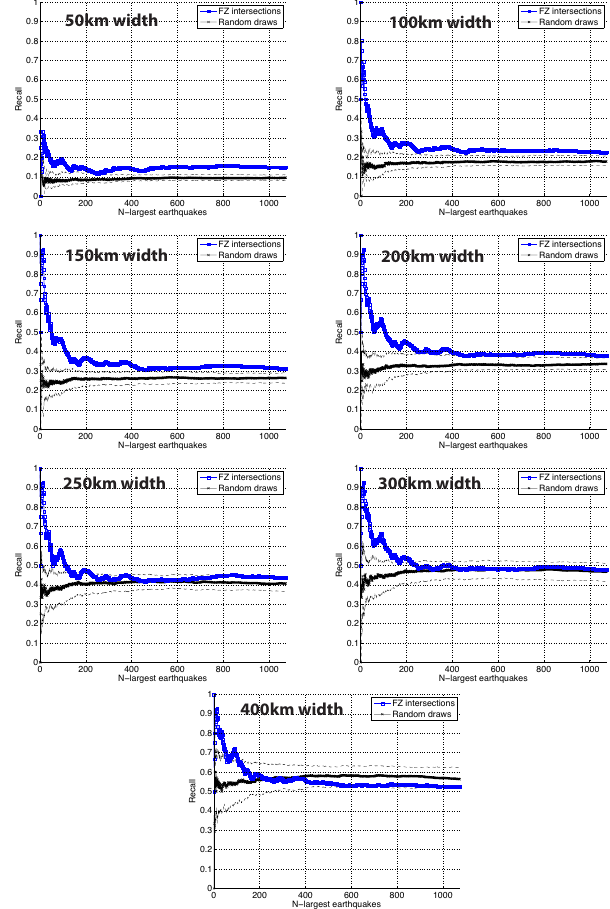
Fig. D1. Top-N sensitivity analysis, demonstrating substantial and significant differences between fracture-zone/subduction-zone in- tersections and the arbitrary case, insensitive to the association proximity